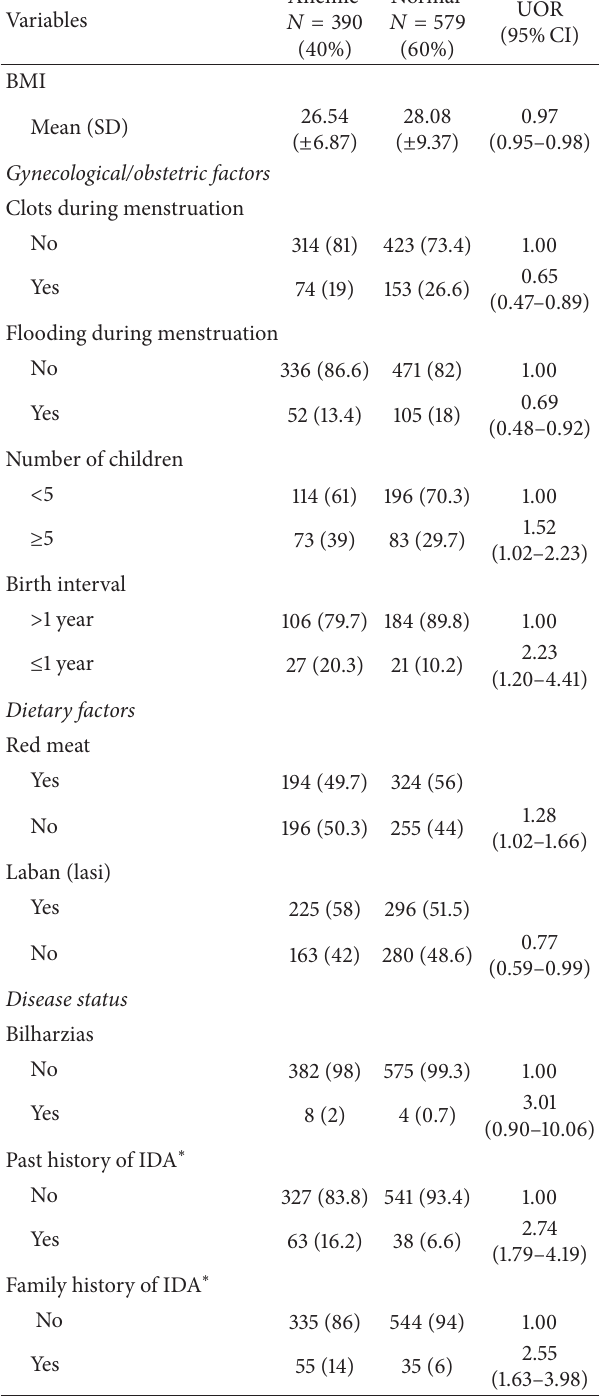
Table 3: Univariate analysis showing association of sociodemo- graphic, gynecological/obstetrics, dietary and health status variables with anemia in child bearing age women, Riyadh, Saudi